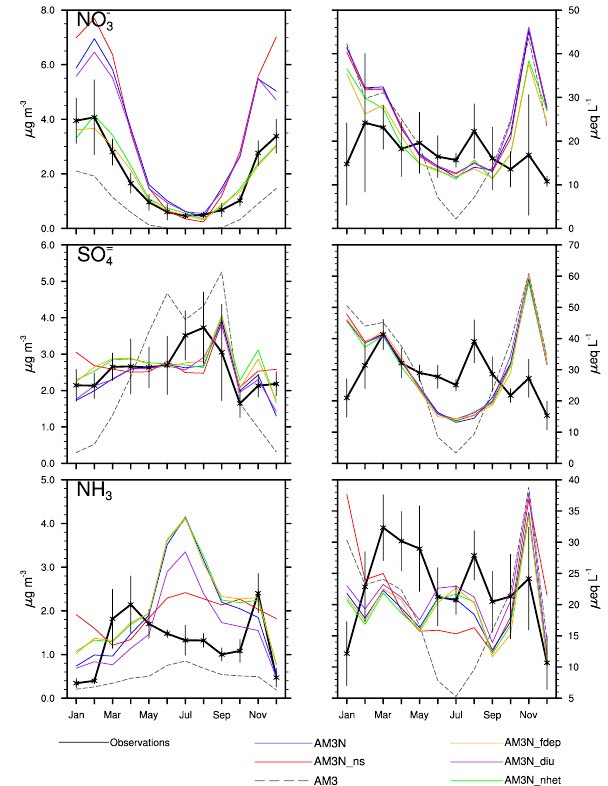
Figure 3. Observed (black) and simulated monthly concentrations of NO − , SO 2 − , and NH 3 at Bondville (40.1 ◦ N, 88.4 ◦ W) in surface 3 4 air (left panel) and precipitated water (right panel). Observations are averaged from 2006 to 2012, while model output is from 2008 to 2010. The vertical bars denote 1 standard deviation of the mean monthly observations. The different model sensitivity experiments are described in Table